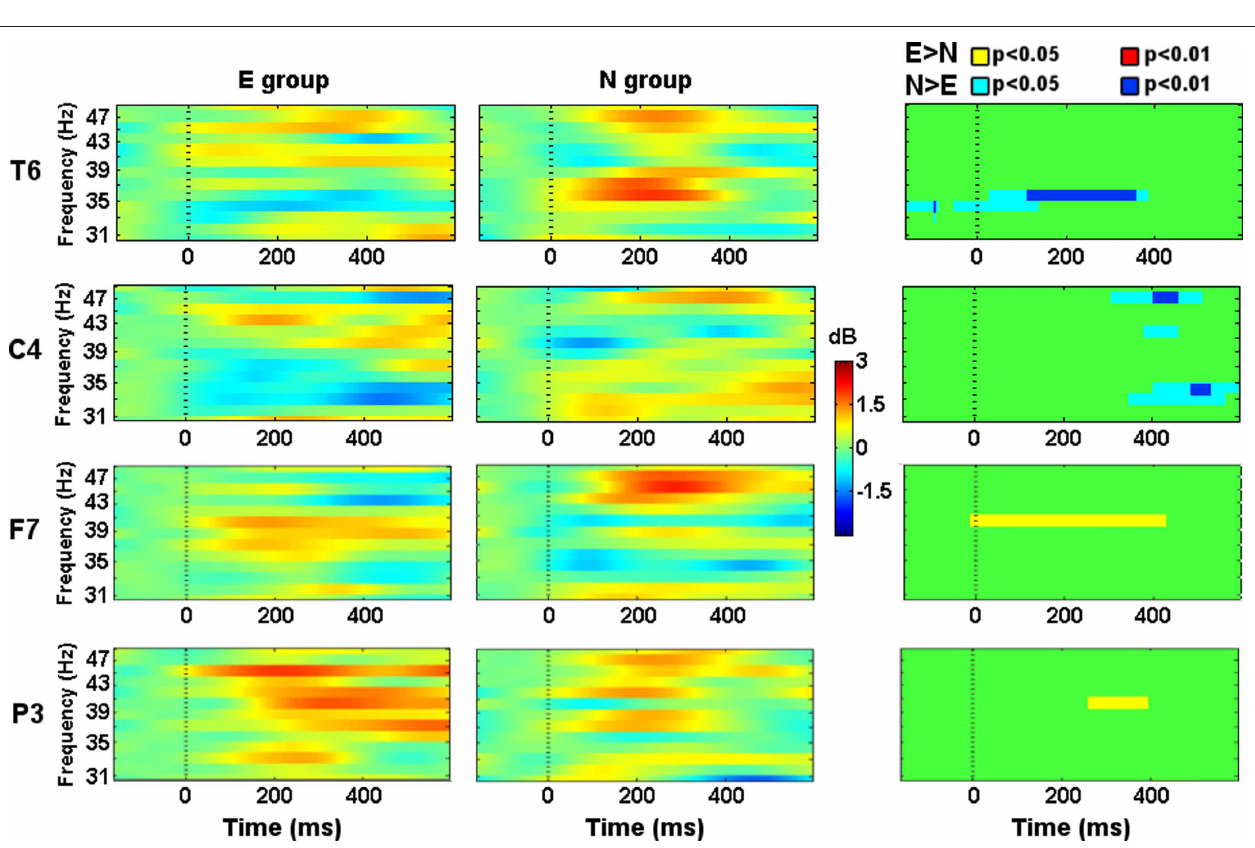
Figure 5 | evoked spectral perturbations in gamma band. Activity recorded from T6, C4, F7, and P3 during Phase 2 stimuli